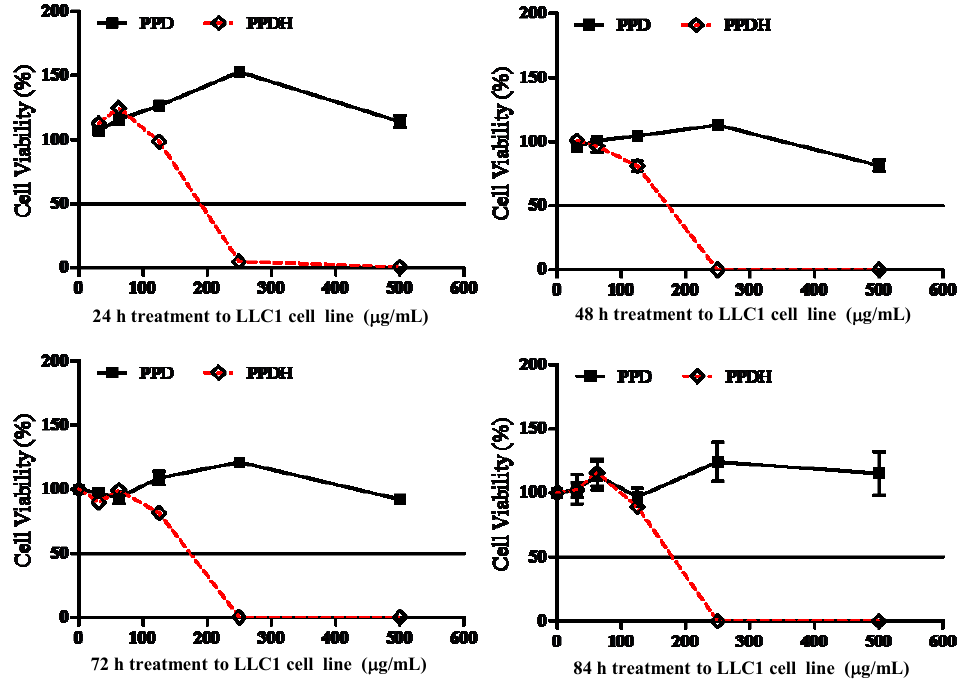
Figure 4. Time and dose-dependent cytotoxicity of PPD and PPDH on LLC1 cells.